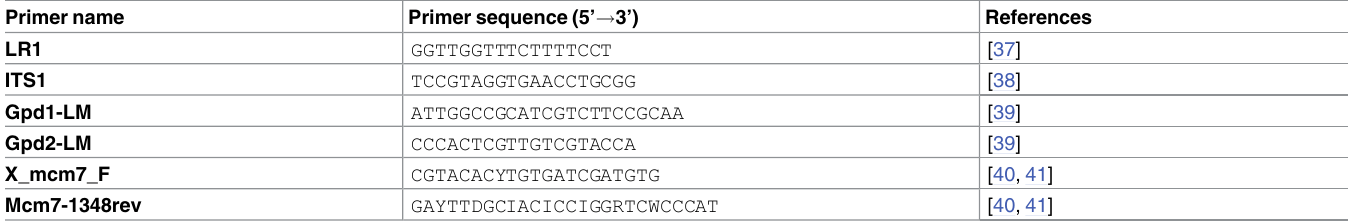
Table 1. The primers used in the